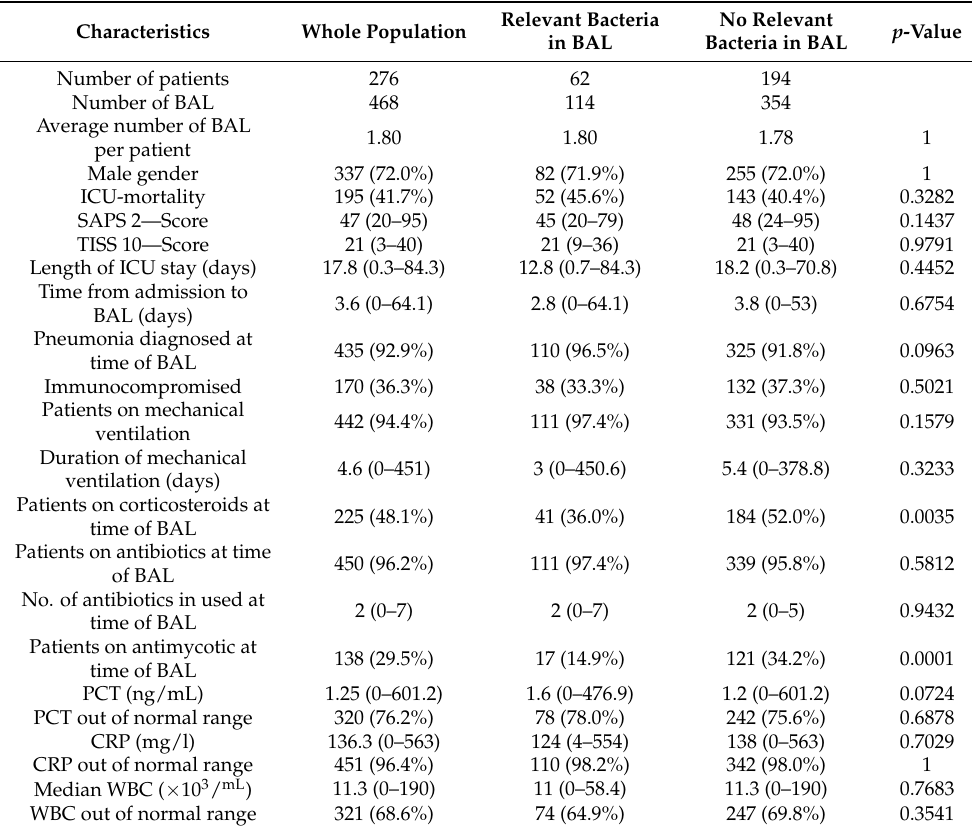
Table 1. Patient